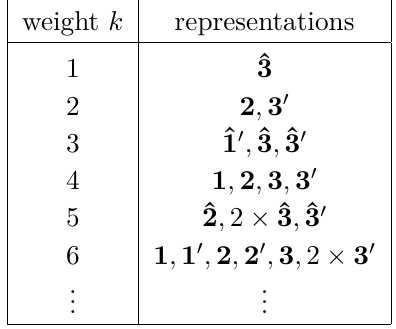
Table 9. Irreducible decomposition of M k (Γ(4))